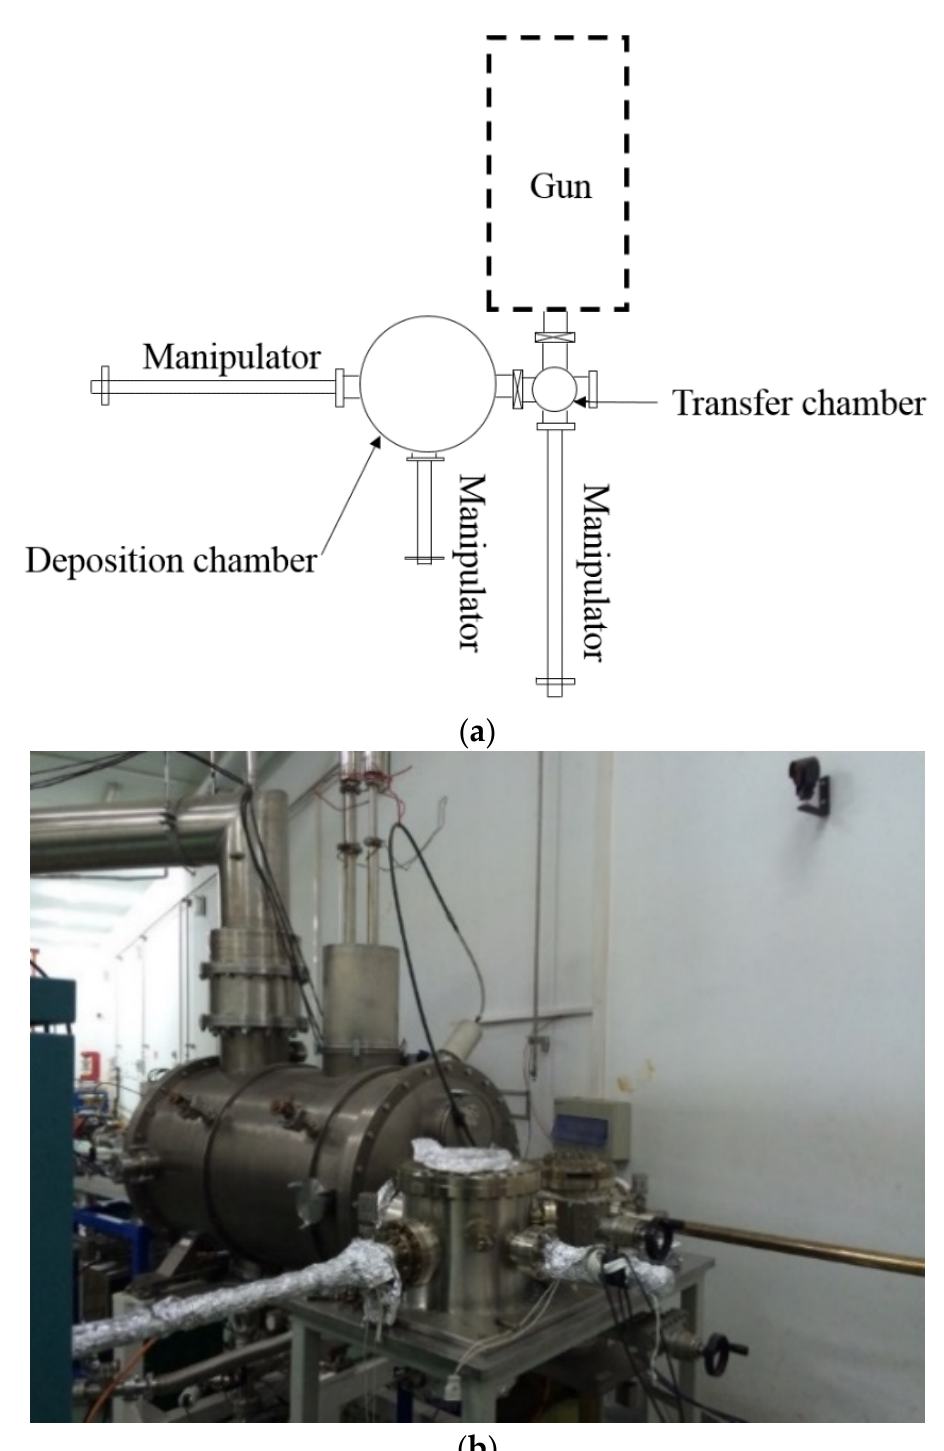
Figure 1. The schematic ( a ) and picture ( b ) of the Cs 2 Te deposition system at PKU.